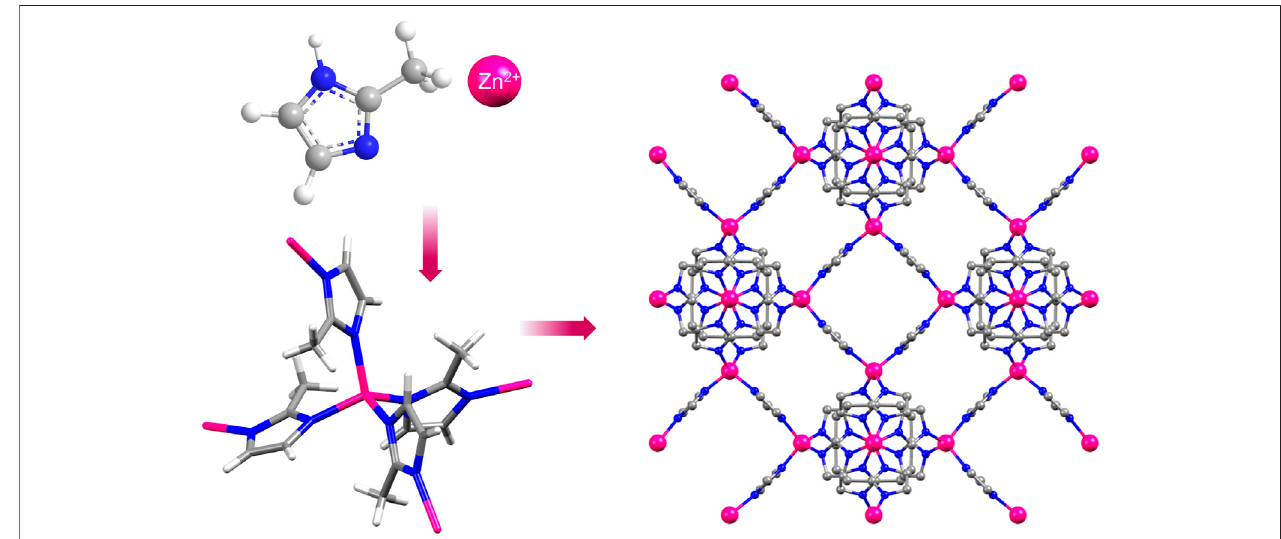
FIGURE10 | Biocompatible and degradable ZIF-8, by Yongan Wang (Yao et al., 2021).